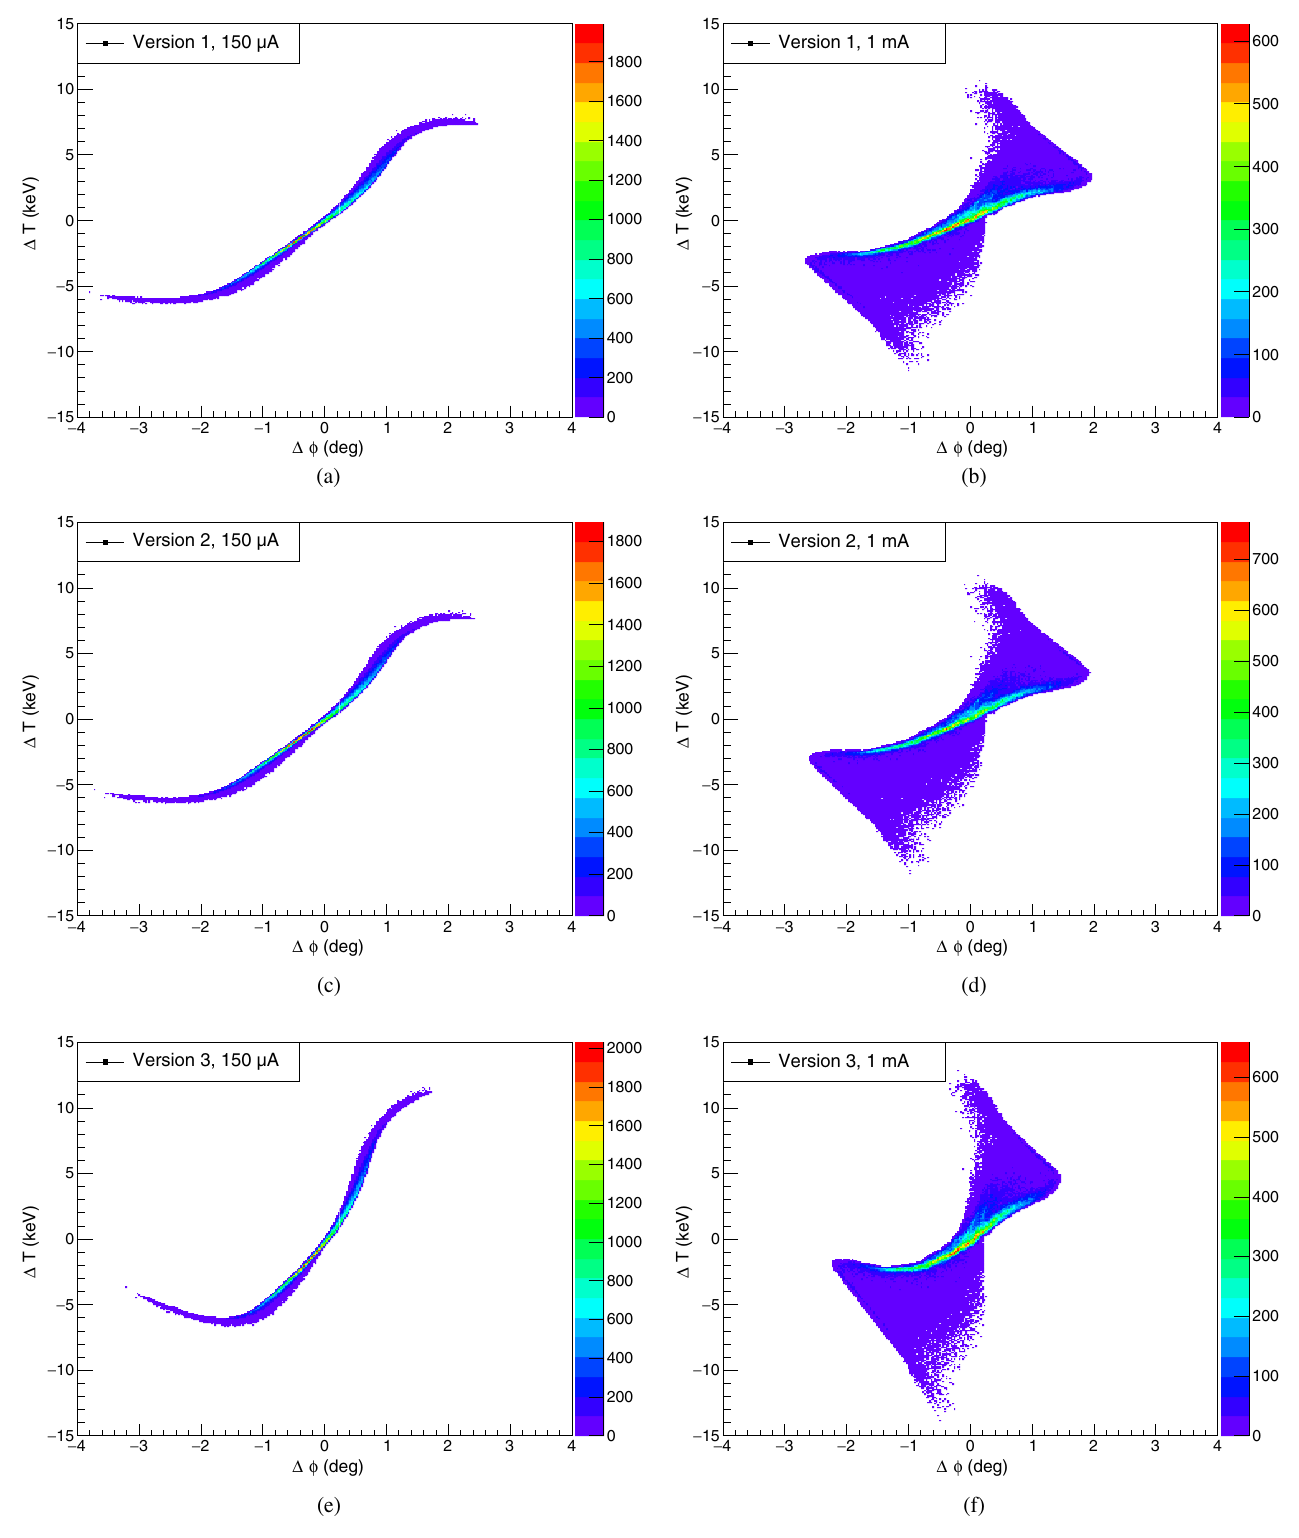
¼ 150 μ A (Figs. 5a, 5c and 5e) and b